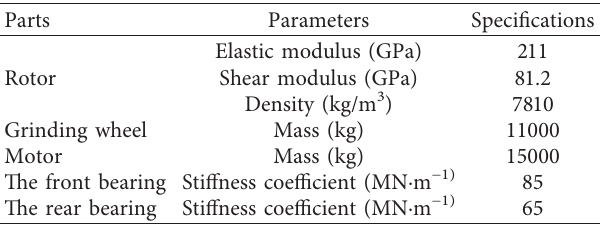
Table 1: The performance parameters of the motorized spindle